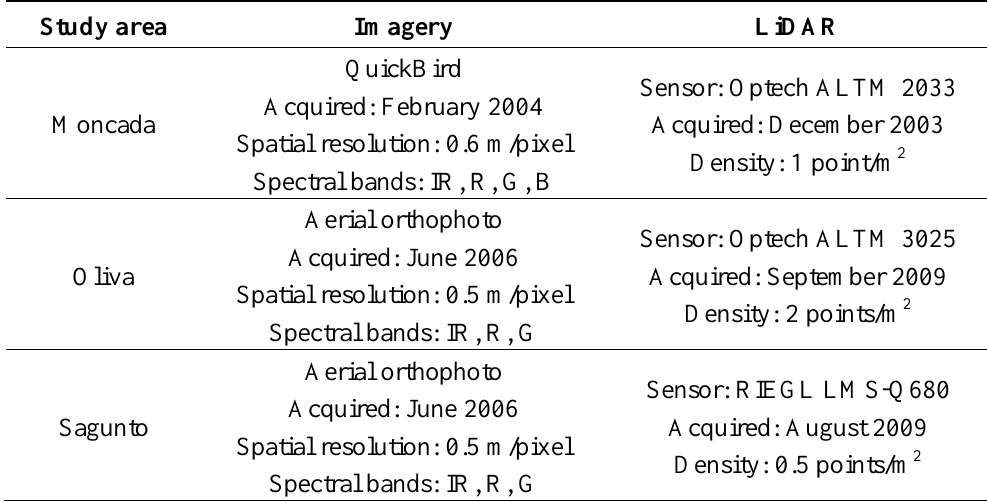
Table 1. Data technical